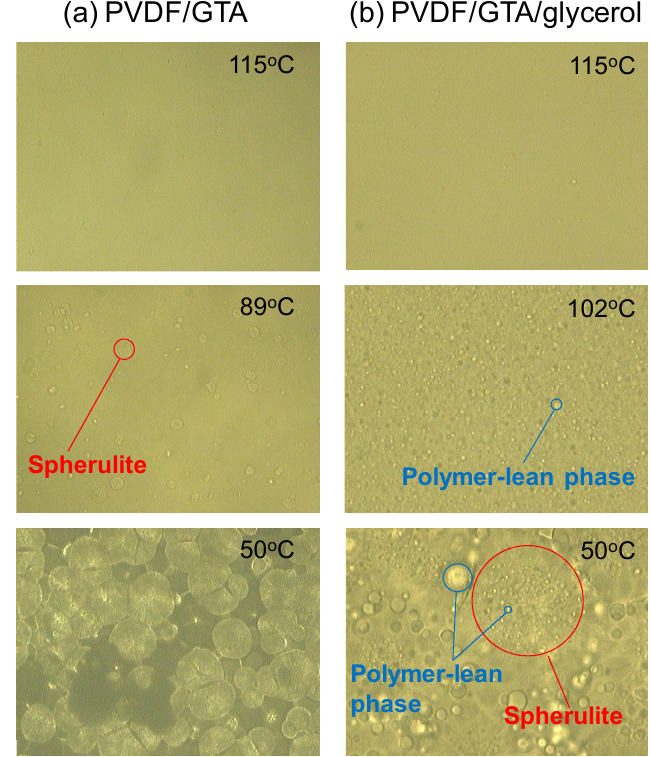
Figure 2. Optical micrographs during phase separation. ( a ) poly(vinylidene fluoride) (PVDF) (30 wt %)/glycerol triacetate (GTA) (70 wt %) system; ( b ) PVDF (30 wt %)/GTA (60 wt %)/glycerol (10 wt %)